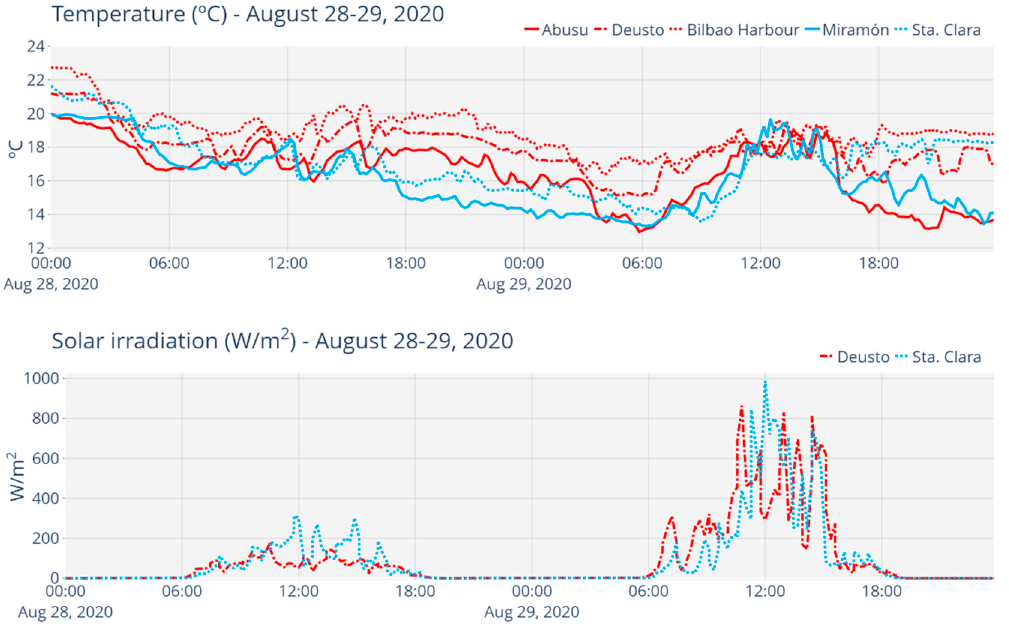
Figure 14. Comparison between recorded temperatures and solar radiation on 28–29 August 2020, on a cloudy day followed by a clear day. Source: authors.